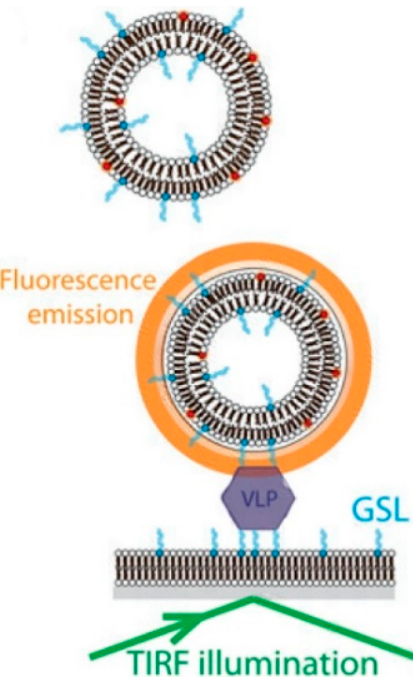
Figure 4. Detection of norovirus-like particles (VLPs) by total internal reflection fluorescence (TIRF). H type 1 glycosphingolipids (GSL) are used as receptors for VLPs. A GSL contained rhodamine-labeled vesicle emits fluorescence after TIRF illumination. (Reprinted from Bally et al. [140] with permission from the publisher).